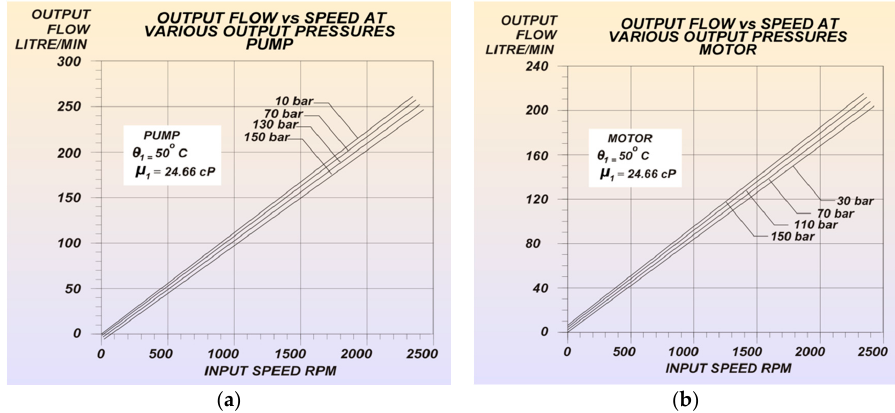
Figure 8. The effective volume flow, Q e , vs. the shaft speed, n , for different pressure differences, ∆ p , at constant temperature and fluid viscosity for a positive displacement ( a ) pump and ( b )